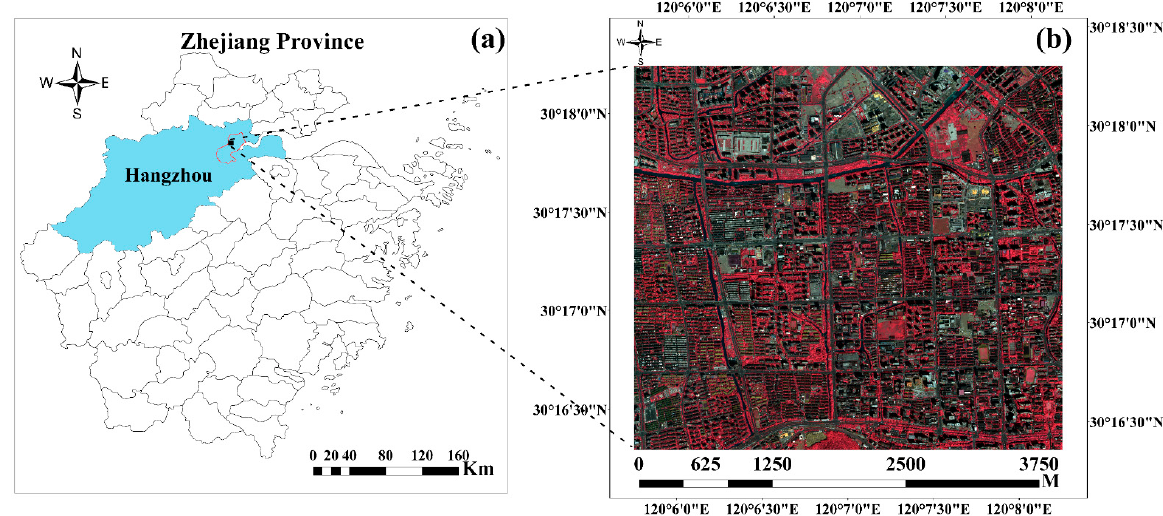
Figure 1. Location of the study area: ( a ) Zhejiang Province. The blue polygon represents Hangzhou; ( b ) the subregion of the West Lake District of